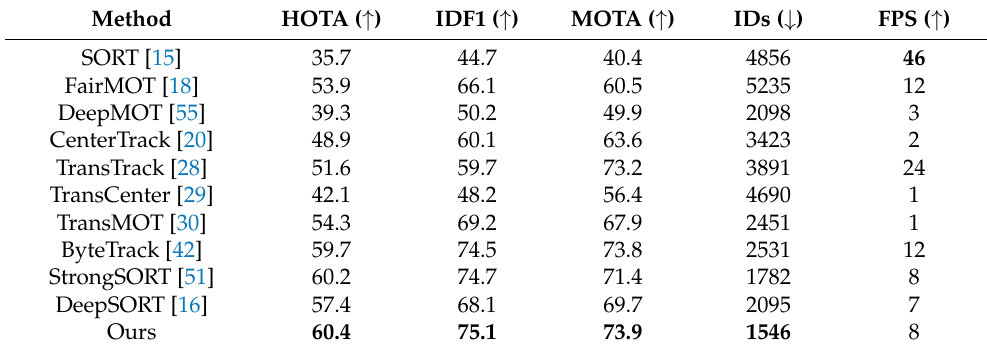
Table 5. Comparison with state-of-the-art MOT methods on the MOT20 test set (improved YOLOv7).